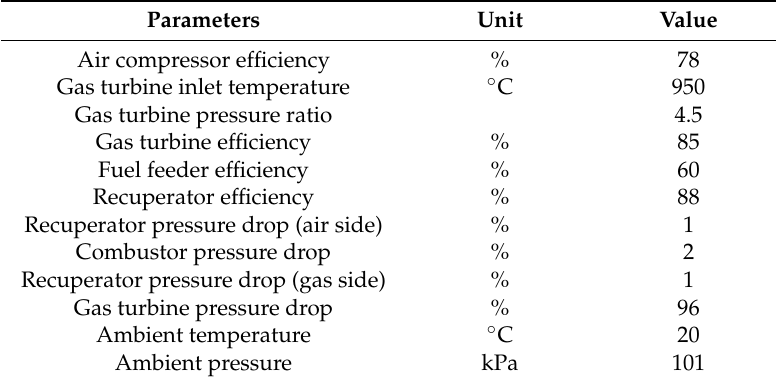
Table 2. Parameters of the micro gas turbine for lumped analysis.